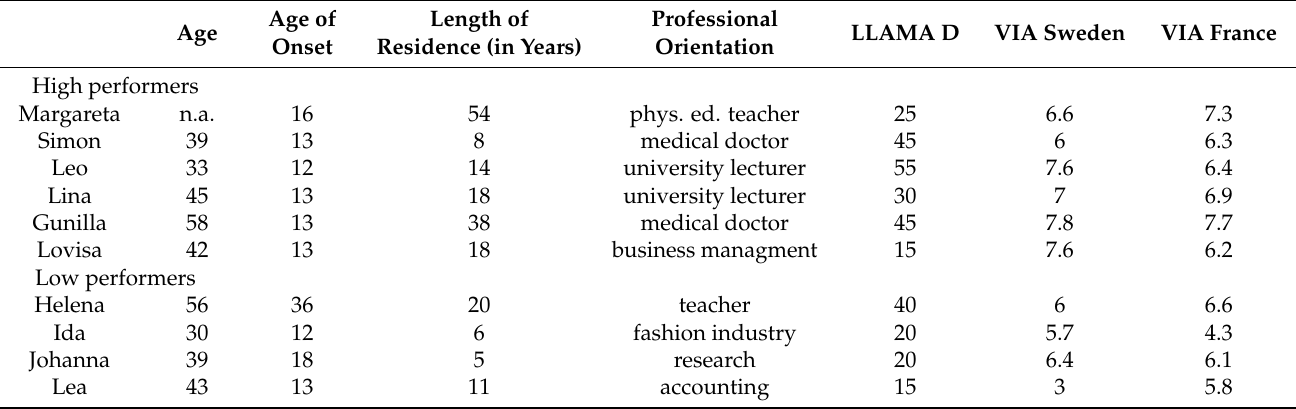
Table 1. Description of